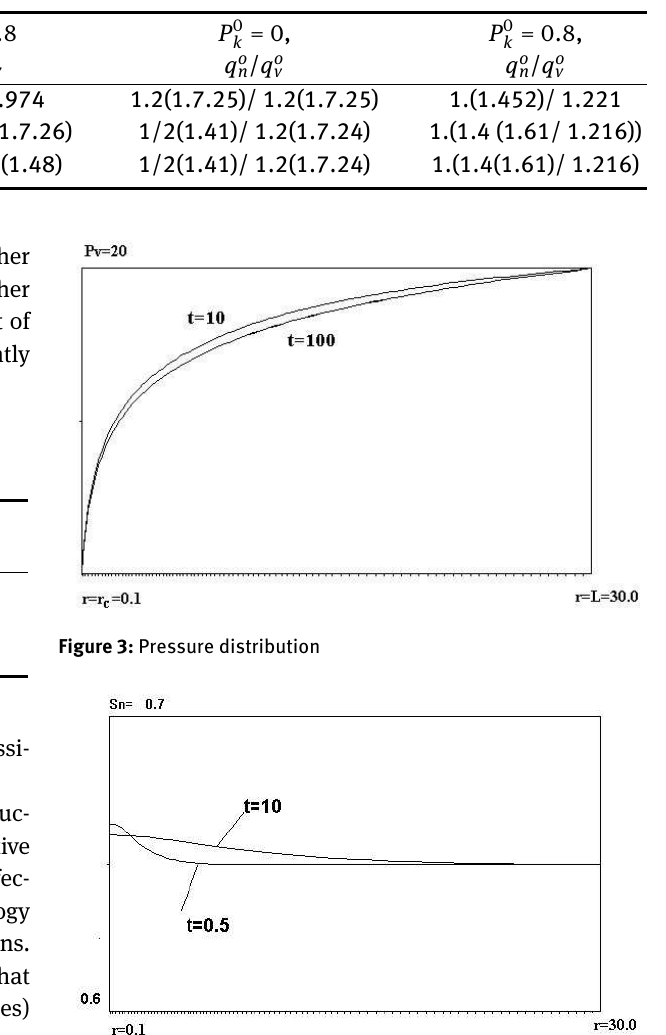
Table 2: Increase in the costs of acid treatment